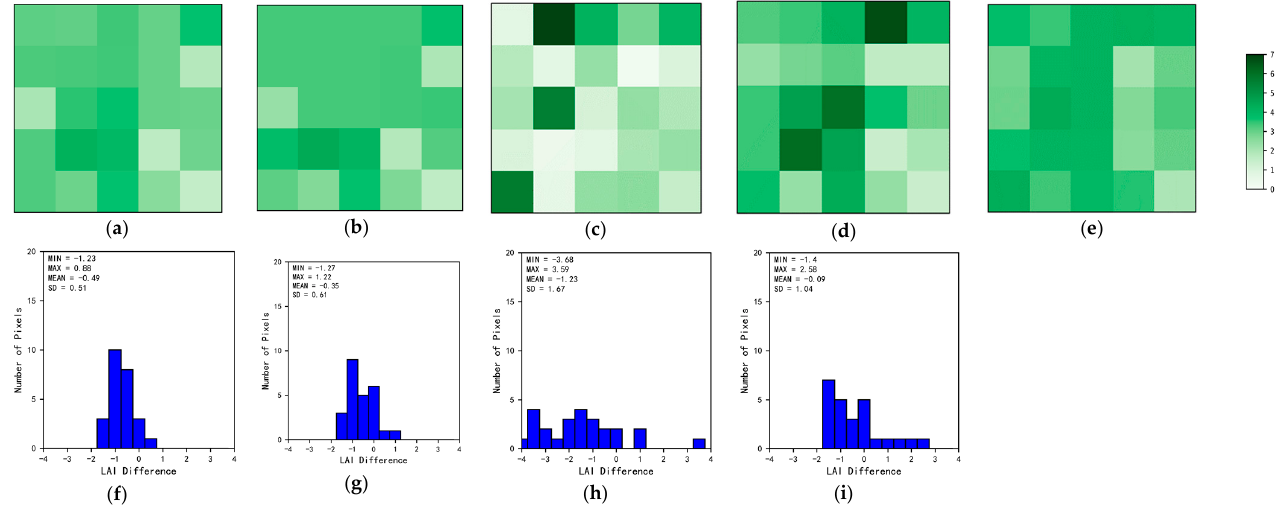
Figure 8. Images of the LAI-TCA ( a ), the LAI-GRNN ( b ), the VIIRS ( c ), the MODIS ( d ) and the LAI values acquired from high-resolution reference maps ( e ) at the Capitanata site on Day 113, 2015. ( f – i ) Statistical distributions of discrepancies between the LAI-TCA, the LAI-GRNN, the VIIRS, the MODIS and the LAI values acquired from high-resolution reference